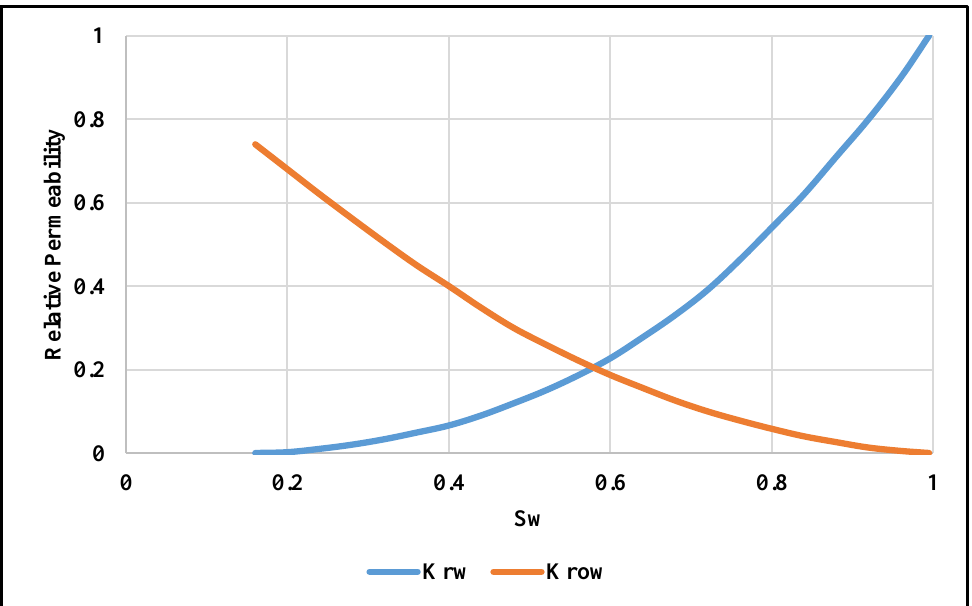
8 of 19 Figure 8. Three-dimensional view of rectangular reservoir model used in simulation. Table 1. Initial reservoir conditions. Parameter